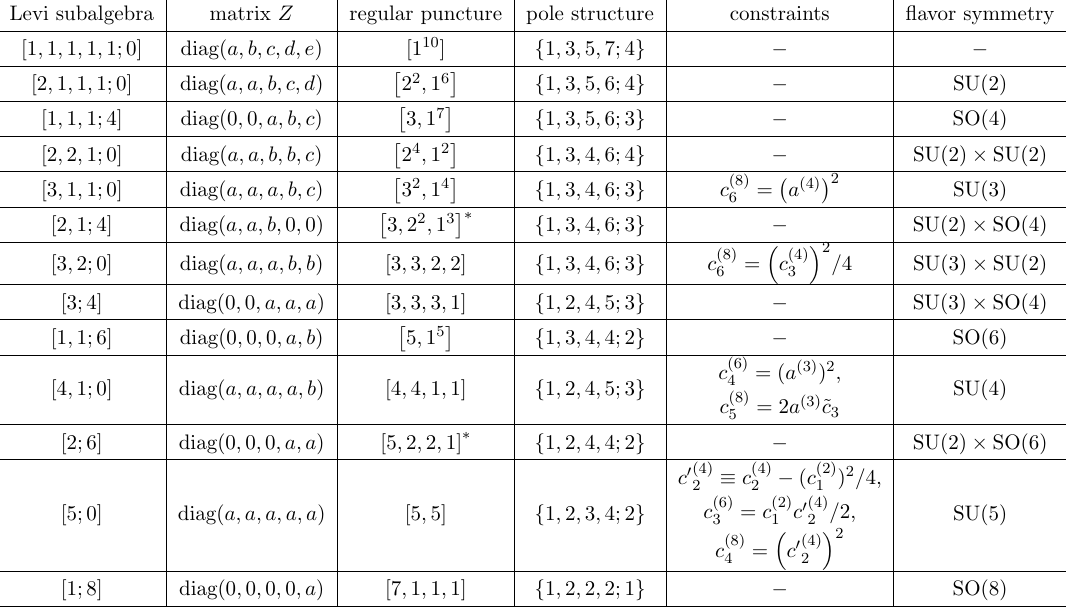
Table 9 . Association of a nilpotent orbit to a Levi subalgebra for D 5 . Z is the convention taken in (2.19). the Nahm partition [5 ; 3 ; 1 ; 1], [7 ; 3] and [9 ; 1] are